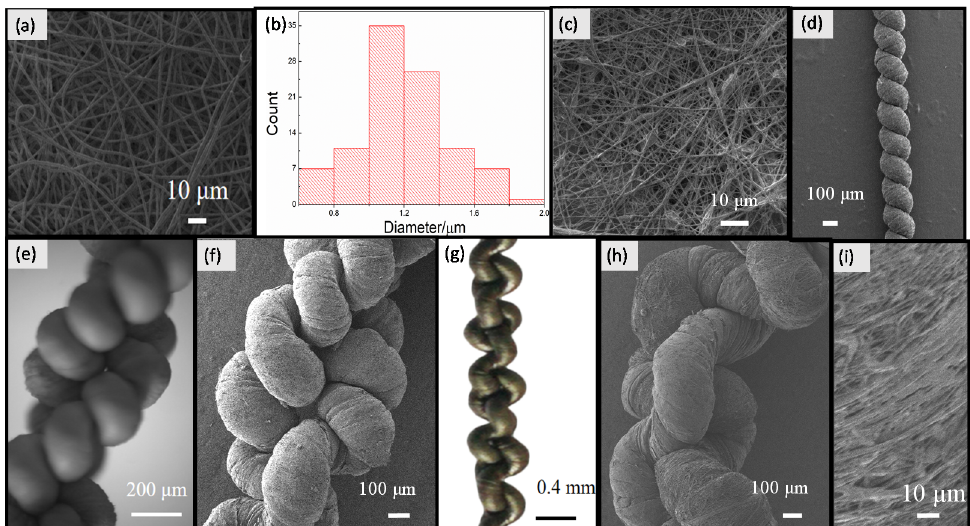
Figure 2. ( a ) Scanning electron microscopy (SEM) image of the TPU nanofibrous membrane; ( b